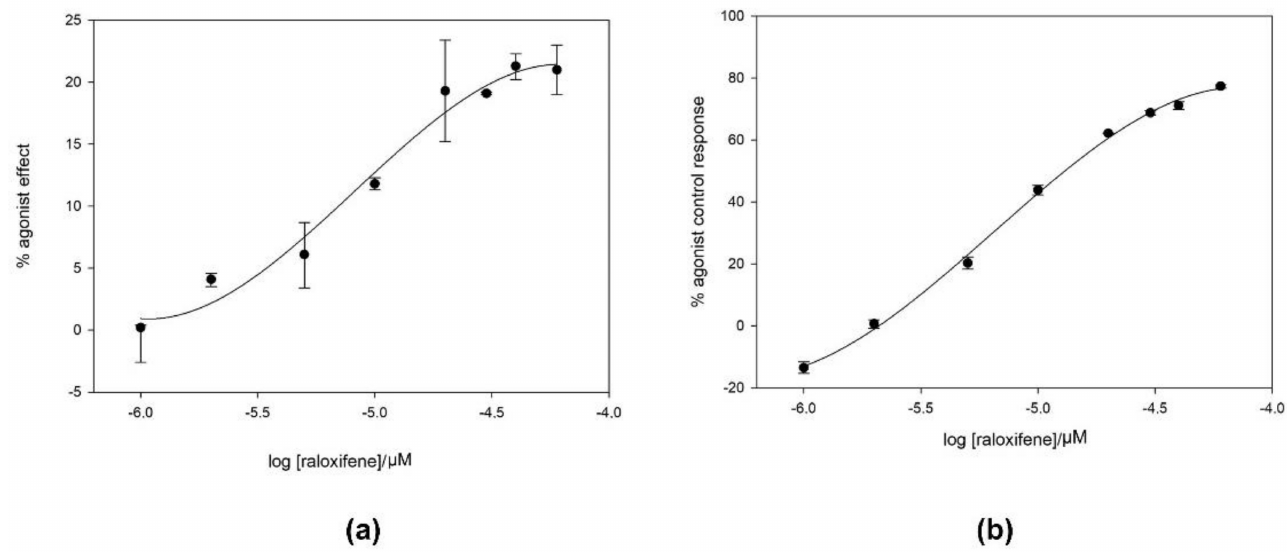
Figure 1. Functional efficacy study of raloxifene on CHO cells stably transfected with the B2 receptor (N = 2). ( a ) Study of the agonistic effect of the compound compared to bradykinin; ( b ) study of the efficacy of the compound antagonizing